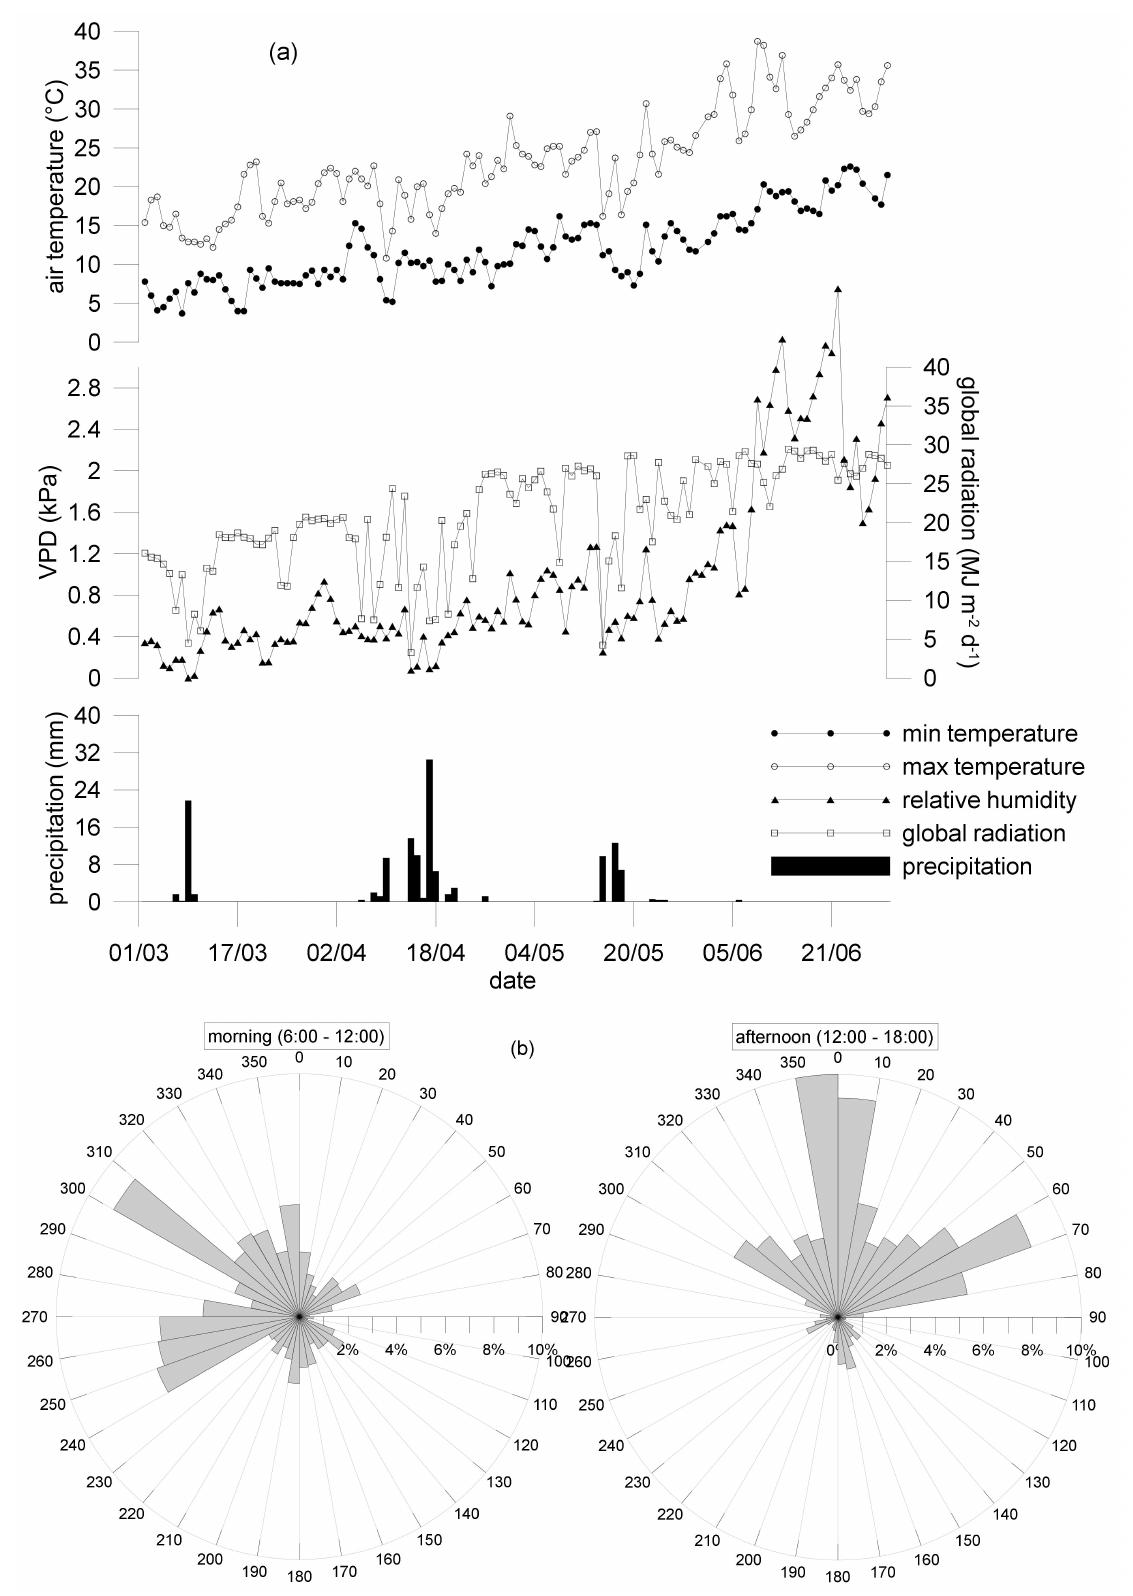
Figure 3. ( a ) Weather patterns during the experiment in terms of daily minimum and maximum air temperature, relative humidity, global radiation, and precipitation (courtesy of Associazione Consorzi di Difesa della Puglia, Italy); ( b ) wind direction during the morning and afternoon as percentage of values per 10 ◦